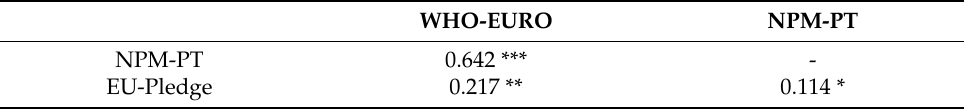
Table 3. Pairwise k values calculated for the three models considered.